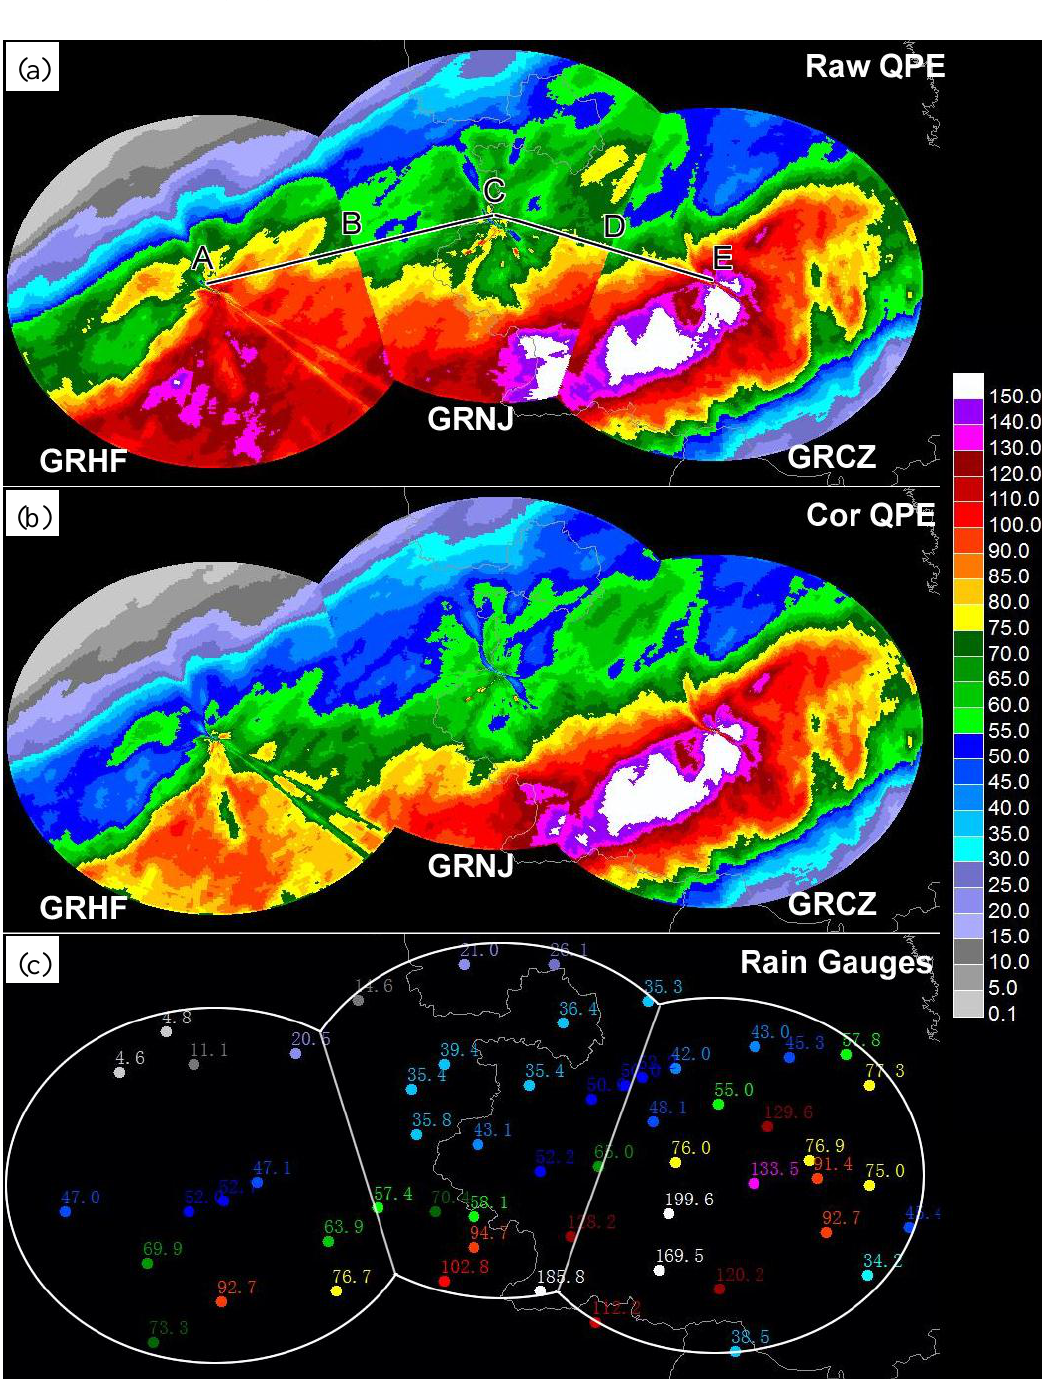
Figure 9. Raw ( a ), corrected ( b ), measured ( c ) 24 h accumulated rainfall for 29 September 2016 precipitation event.